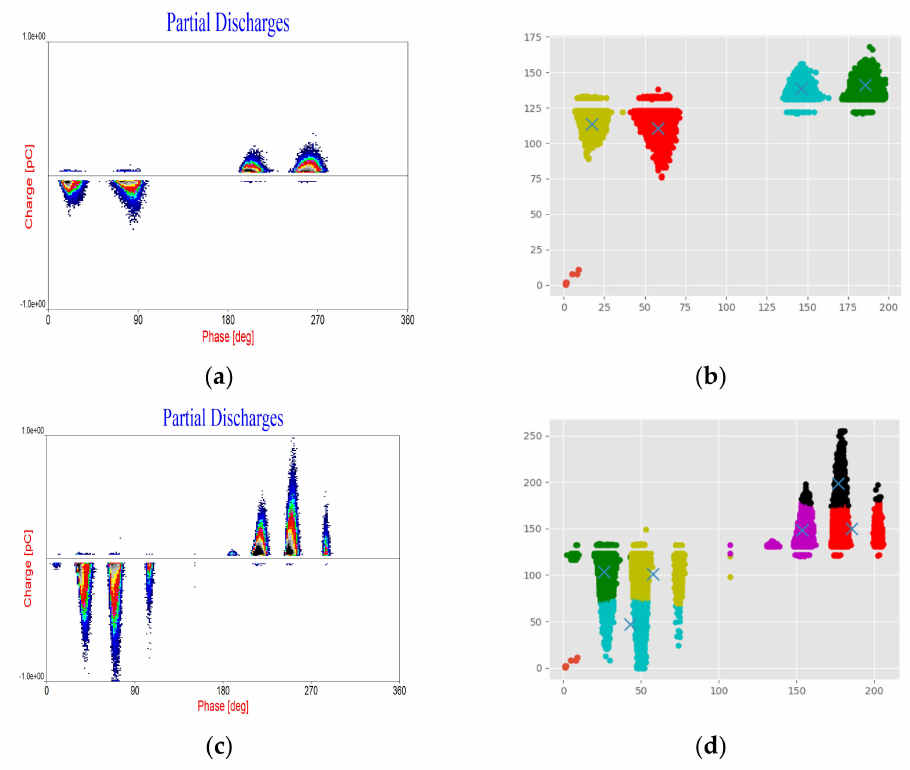
Figure 6. Segmentation of PD image containing higher harmonics: ( a ) 3rd and 5th harmonics at 50-Hz high voltage; ( b ) K-means-based extraction of four clusters; ( c ) modulation of PD image by the 11th harmonic; ( d ) extraction of six